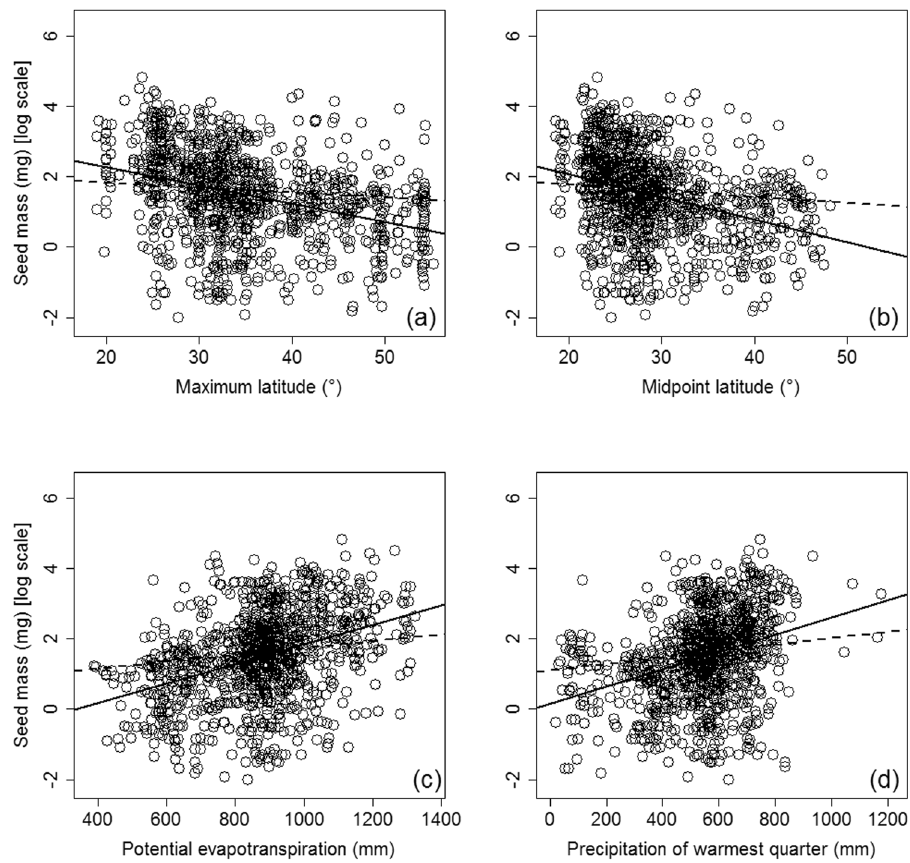
Figure 1. Associations between seed mass and maximum latitude, mid-point latitude, potential evapotranspiration and precipitation in warmest quarter, for 1055 woody species with coordinates and climate data available. Solid line represent result of linear regression, while dashed line represent that of phylogenetic